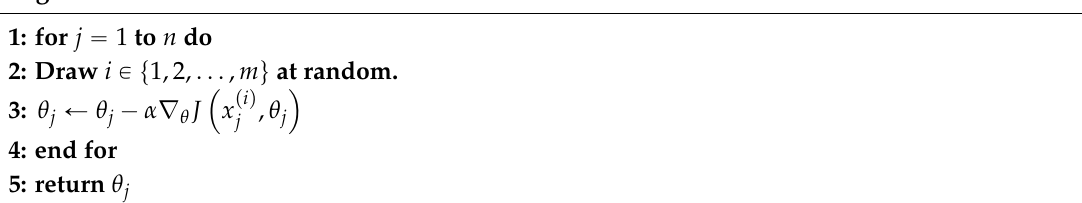
Algorithm 2 Fast Stochastic Gradient Descent